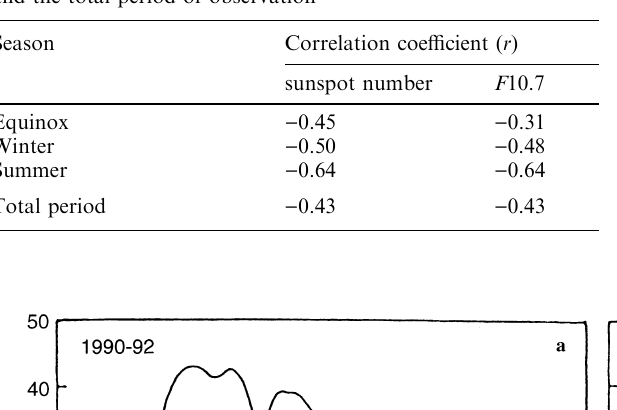
Table 2. The correlation coe(cid:129)cients of occurrence of daytime scintillations with sunspot number and F 10.7 for the three seasons and the total period of observation